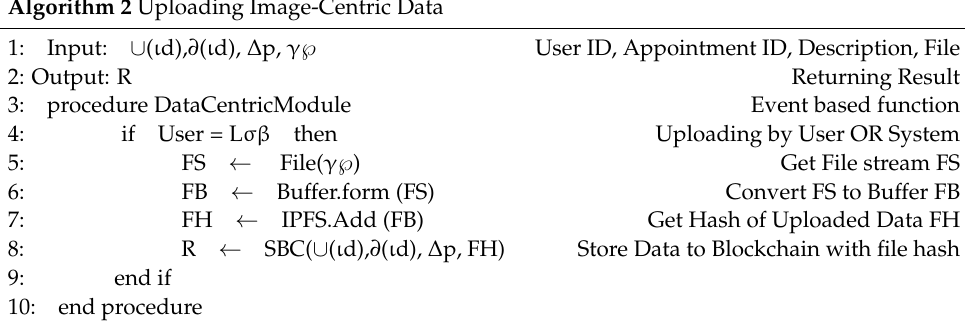
Algorithm 2 Uploading Image-Centric